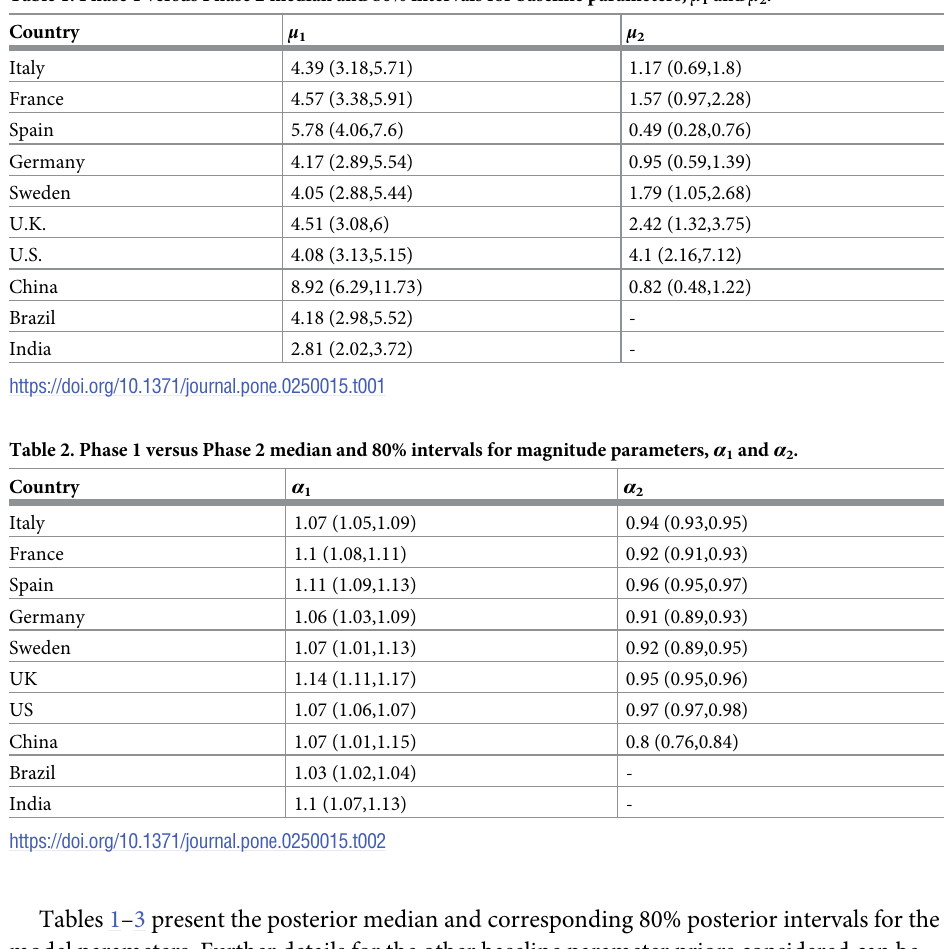
is consistently lower 2 1